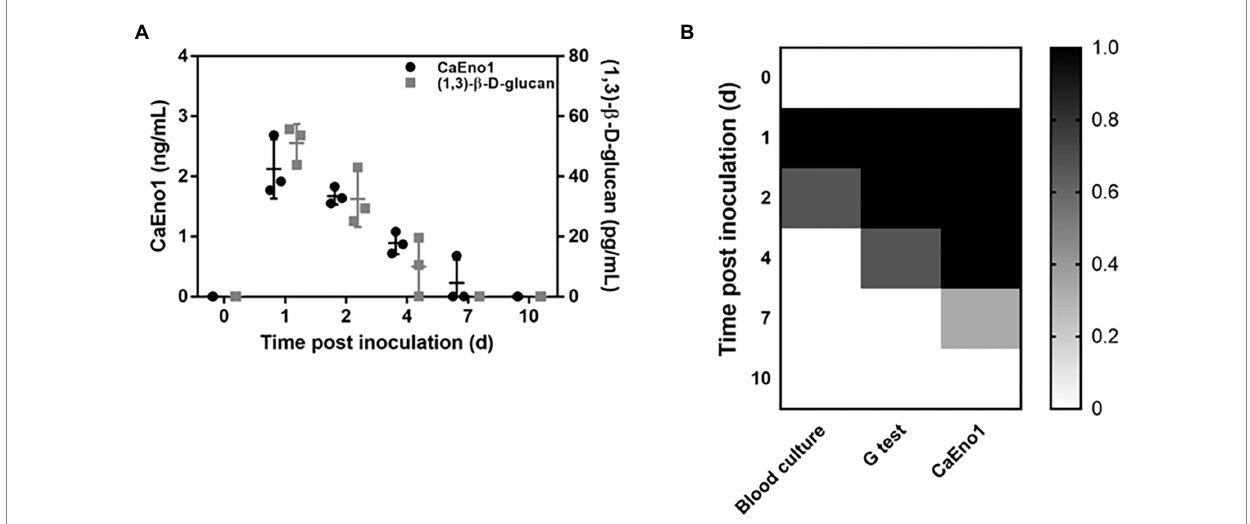
FIGURE 4 Dynamics of CaEno1 and its diagnostic efficiency in comparison to the G -test and blood culture. (A) Dynamics of CaEno1 and (1,3)- β -D-glucan (cut- off, 10 pg./ml) in rabbit blood after Candida albicans inoculation; (B) Diagnostic efficiency of CaEno1 detection, G -test, and the blood culture.